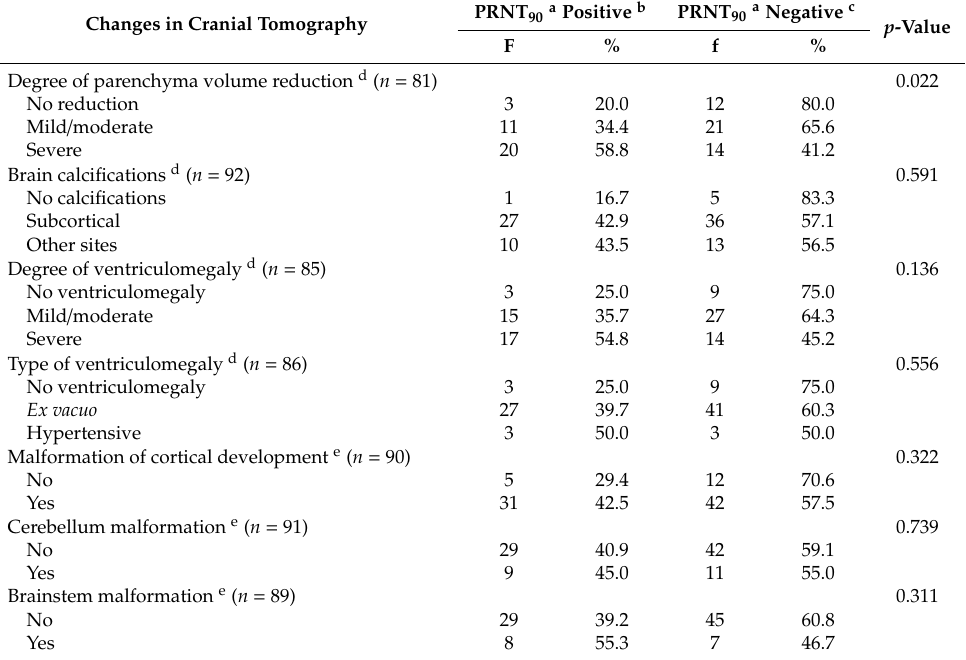
Table 5. Changes in cranial tomography and positive and negative plaque reduction neutralization test in children with CZS. S ã o Lu í s, Brazil, 2016–2018. PRNT 90 a Positive Changes in Cranial Tomography